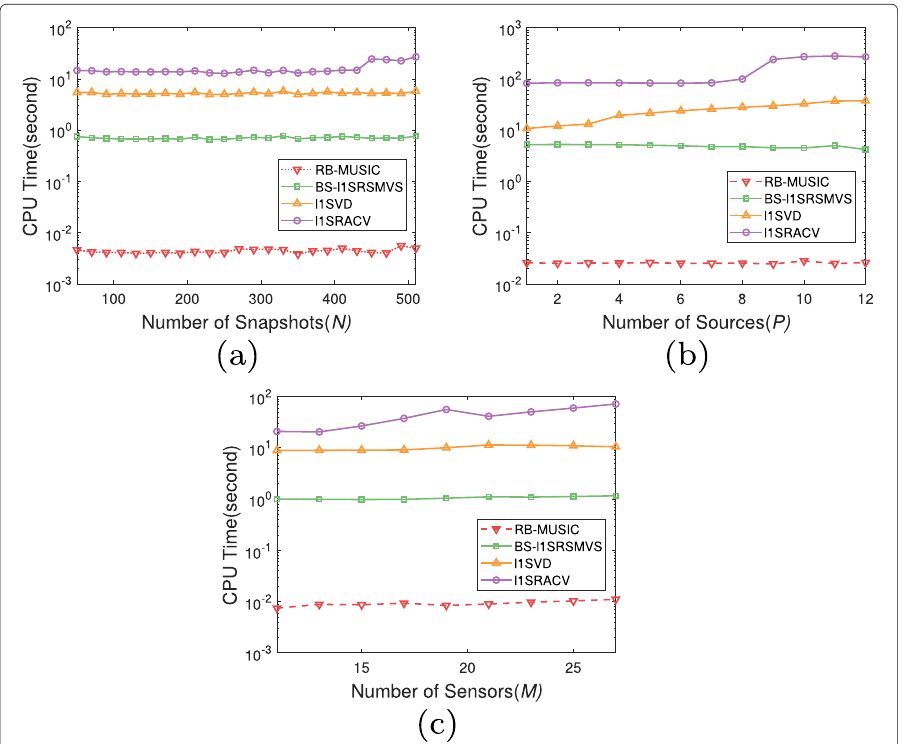
Fig. 8 CPU time comparisons of BS- (cid:2) 1 -SRSMVS, (cid:2) 1 -SVD, (cid:2) 1 -SRACV and RB-MUSIC. a CPU time versus snapshots N , M = 18, r /λ =0.5, SNR = 20 dB . b CPU time versus number of sources P , M = 28, r /λ =0.5, SNR = 20 dB . c CPU time versus number of sensors M , H e =5, N = 500, r /λ =0.5, SNR = 20